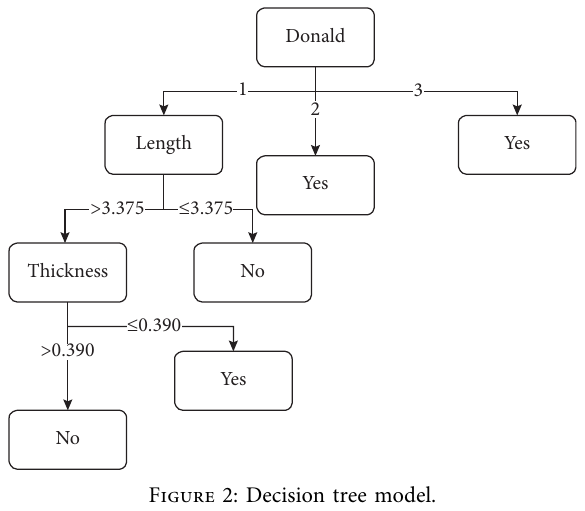
Figure 2: Decision tree model.